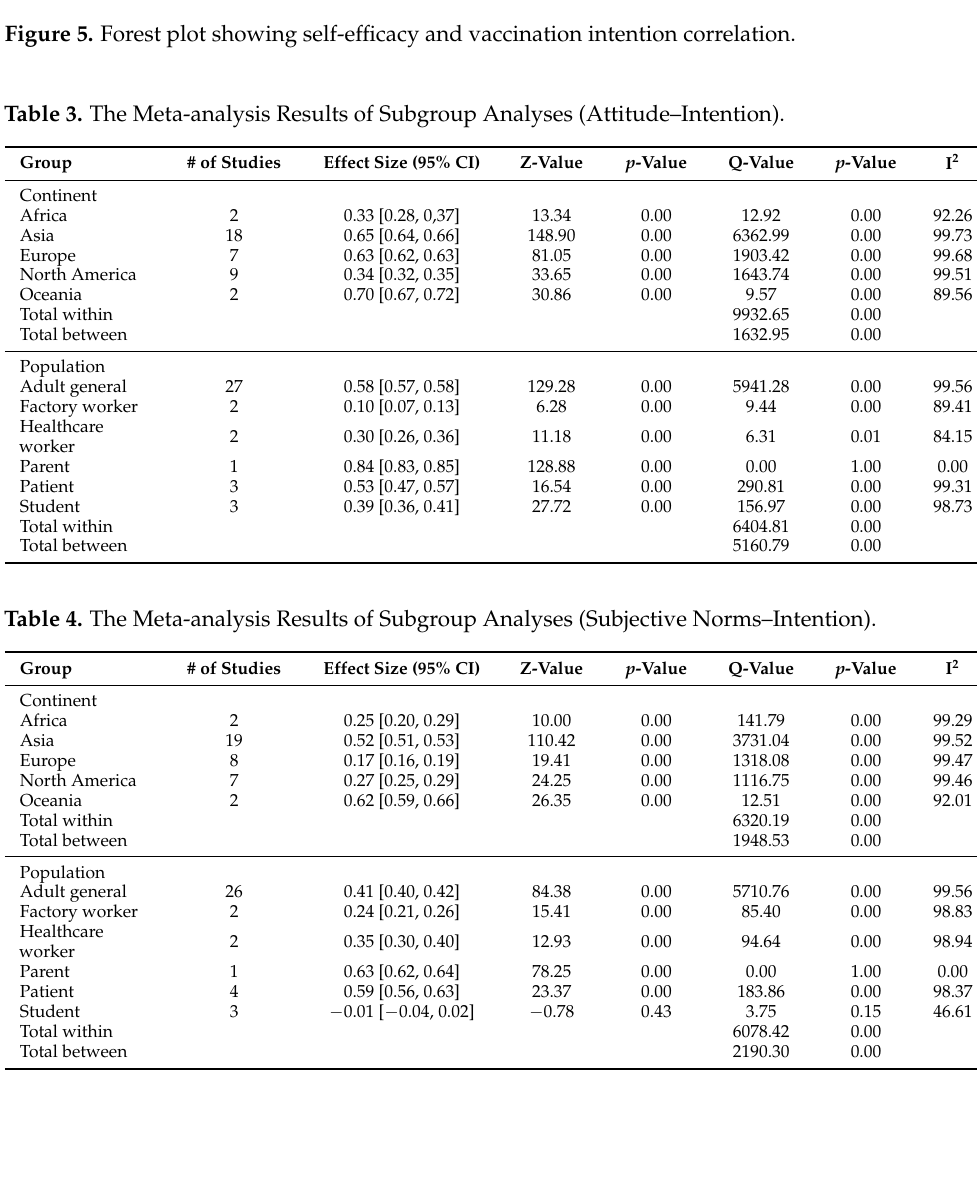
Figure 5. Forest plot showing self-efficacy and vaccination intention correlation.